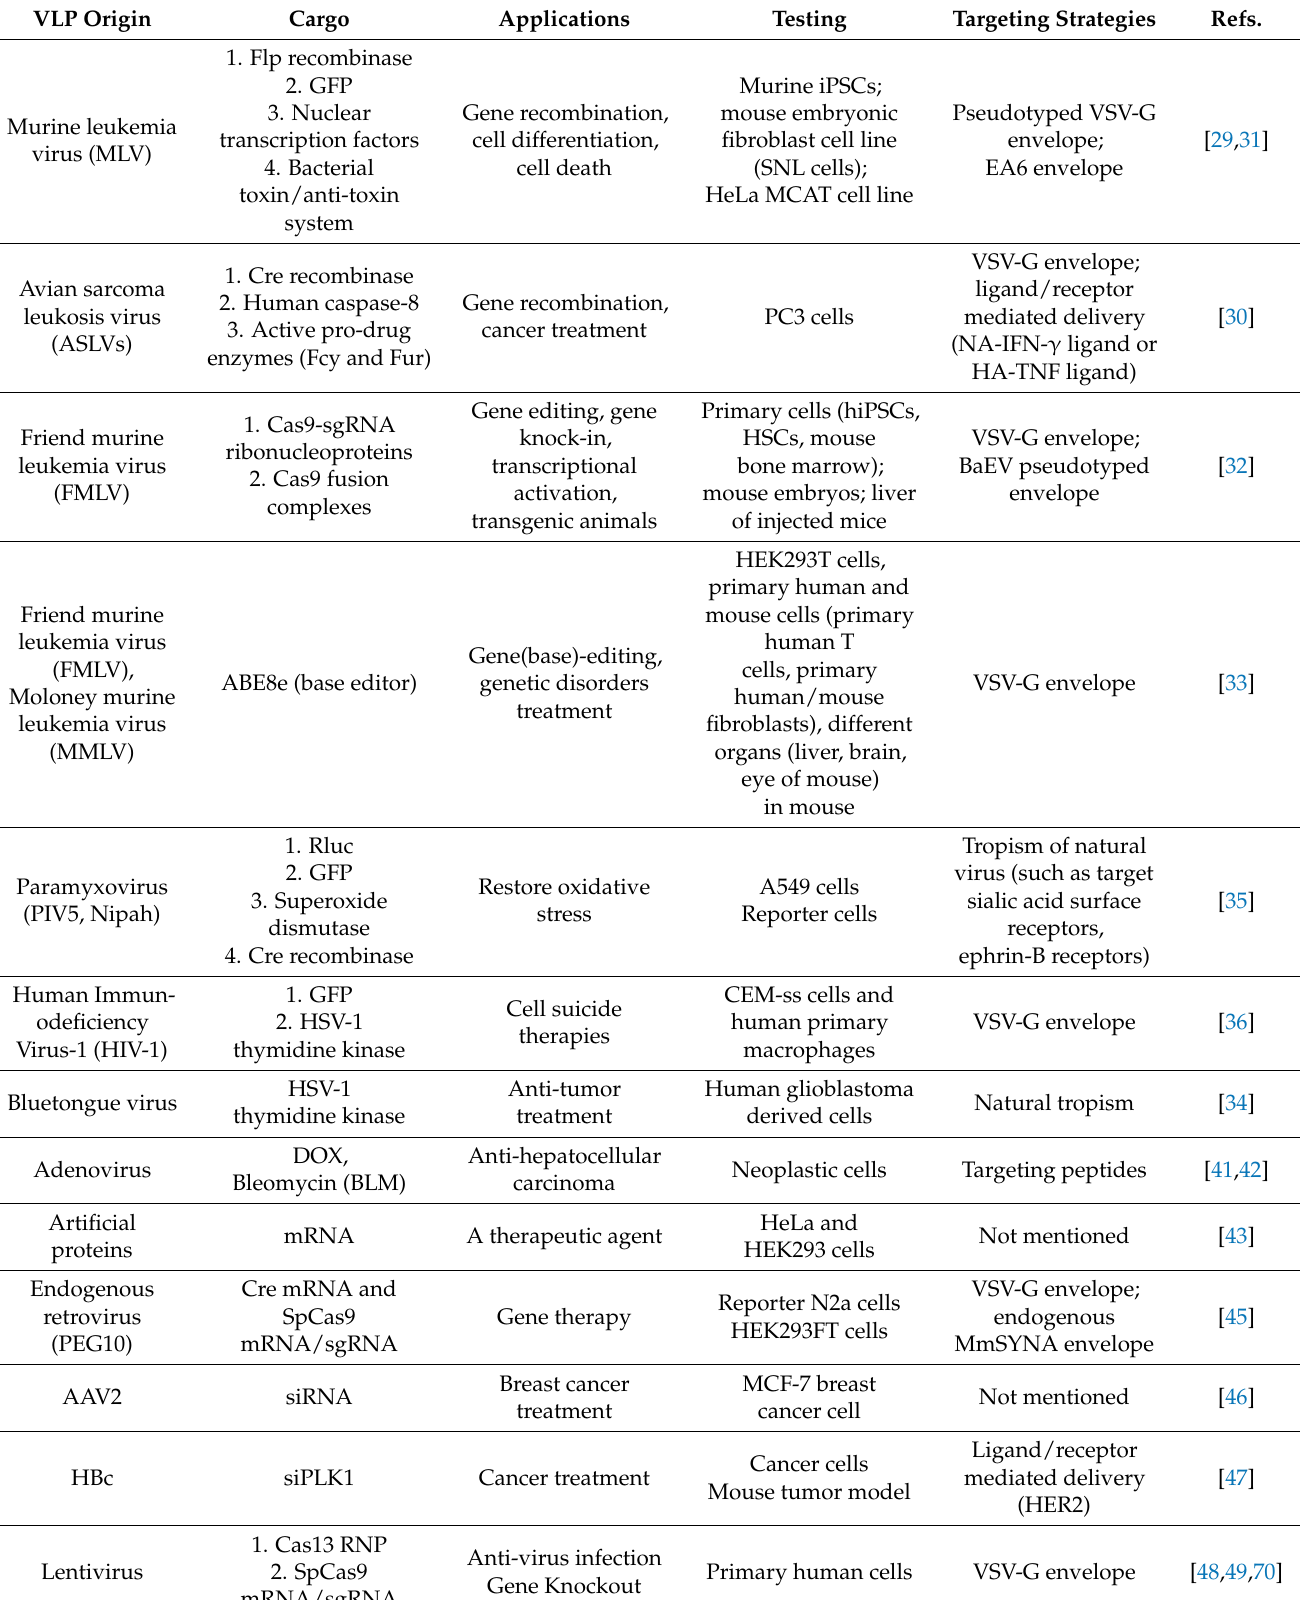
Table 2. Applications of VLP-mediated cargo